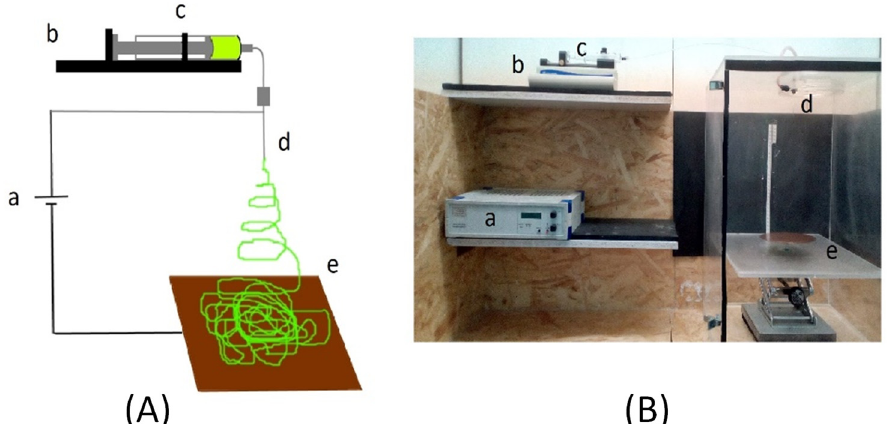
Figure 3. Schema ( A ) and photographs ( B ) of the electrospinning set-up (high electric voltage source (a), circulation pump (b), syringe (c), stainless steel needle (d) and cooper collector (e)).